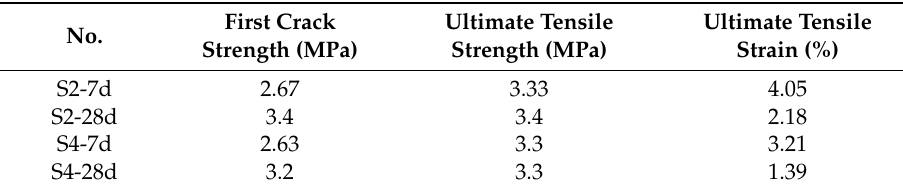
Table 11. Tensile properties of S4 and S2.